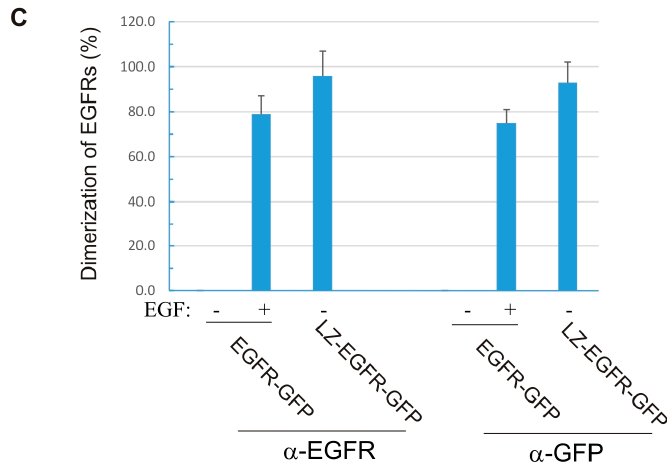
Figure 2. Expression and dimerization of LZ-EGFR-GFP. 293T cells were transiently transfected with LZ-EGFR-GFP, EGFR-GFP or empty vector (GFP). ( A ) EGFR-GFP and LZ-EGFR-GFP were visualized by immunoblotting of the total lysates with antibodies to either EGFR or GFP; ( B ) Cells were crosslinked with disulfosuccinimidyl suberate (DSS). Both LZ-EGFR-GFP monomer (105 kD) and dimer (210 kD) were visible in the resulting immunoblots. EGFR-GFP dimerized only after EGF stimulation, as expected; ( C ) Quantification of the data from ( B ). The band is quantitated by densitometry with image J software (National Institute of Health, Bethesda, MD, USA) and the receptor dimerization was expressed as the percentage of dimers among the total receptor proteins. Each value is the mean of at least three independent experiments and the error bar represents the standard error.